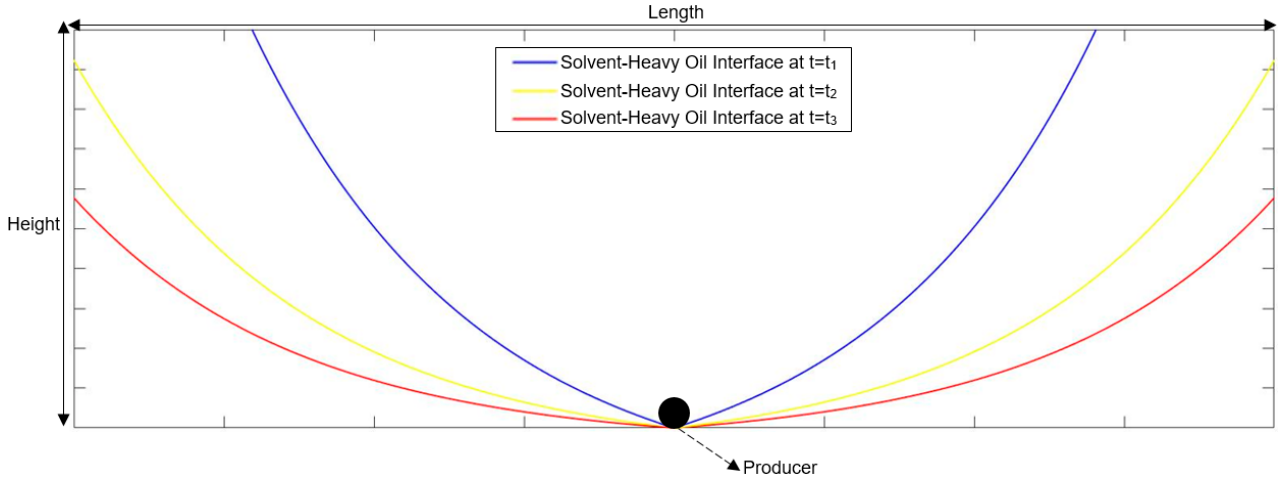
Figure 1. Concave exponential propagation of solvent chamber throughout the spreading and falling stages.